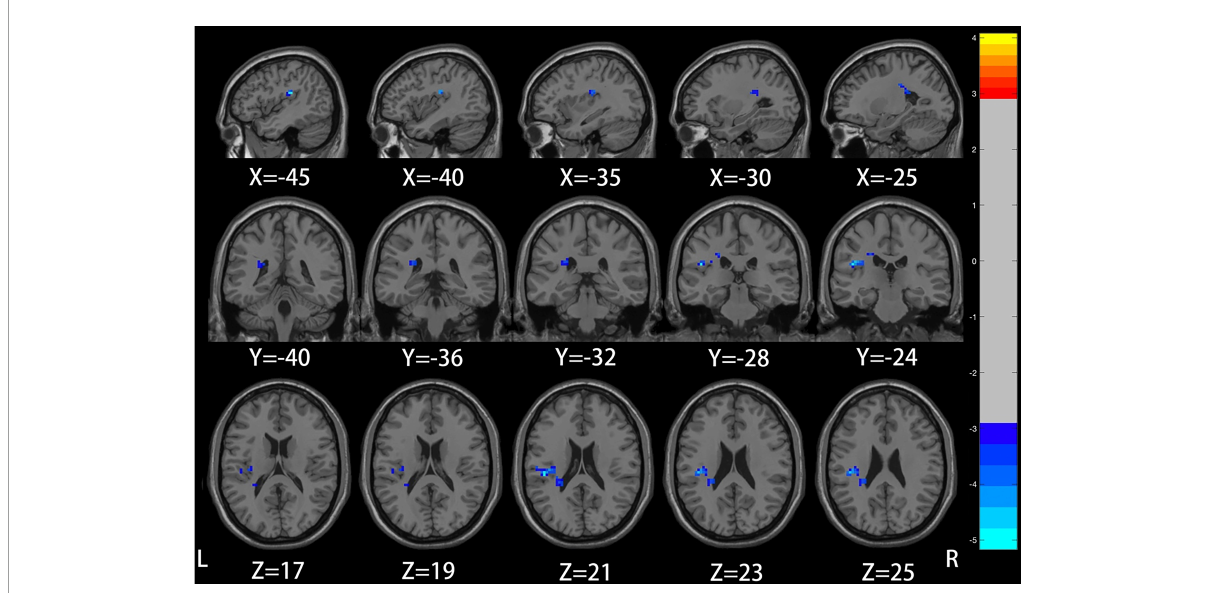
FIGURE2 Compared to healthy controls, the region of reduced degree centrality (DC) in mild to moderate depression patients was located in the left insula.